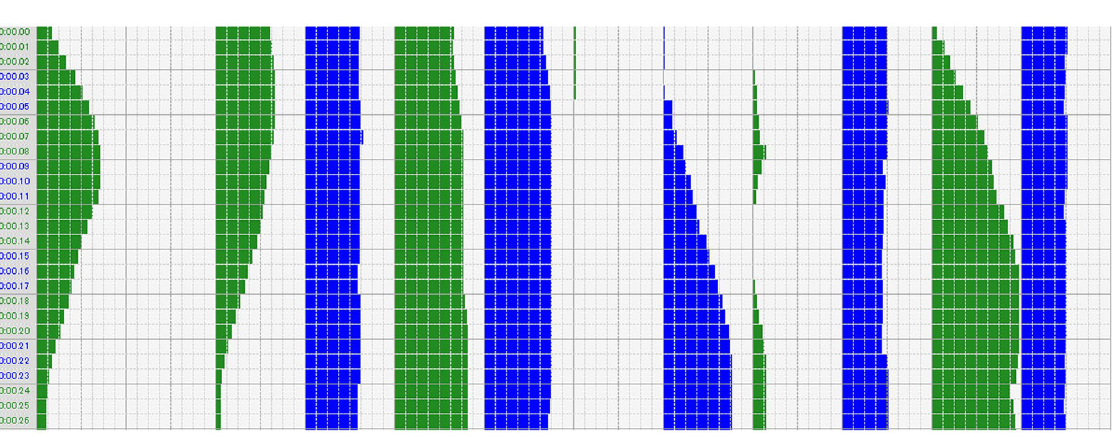
Fig 2. Sample fragment of the action encoder for